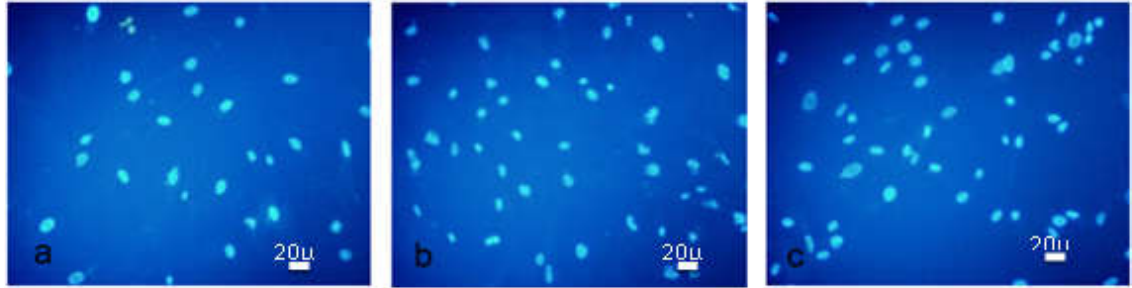
Fig. 1. Fluorescent micrograph of BMSCs stained with Hoechst, after 36 hours of treatment with MI. Differences in the size of the nuclei can be observed in both the treated groups (b and c) compared to control one (a). Magnification: